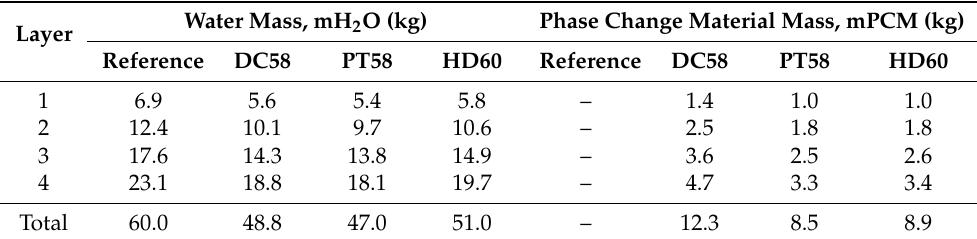
Table 10. Water and phase change material masses included in the test tank for each layer.